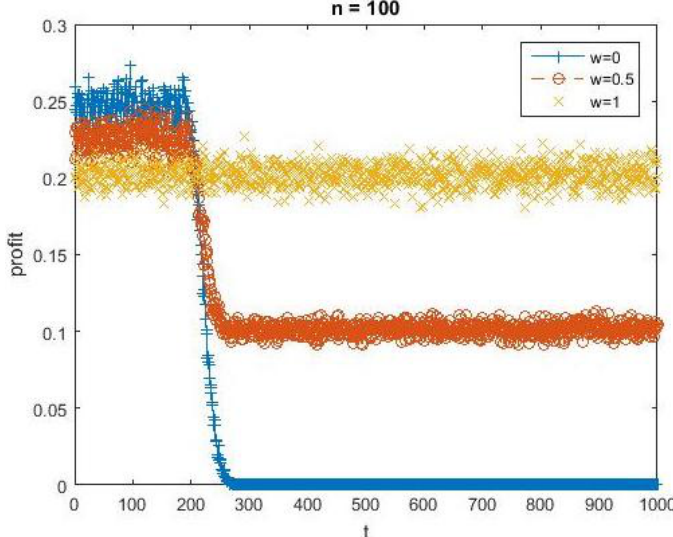
Figure 3. Criminal’s profit over time for three different values of w when c =